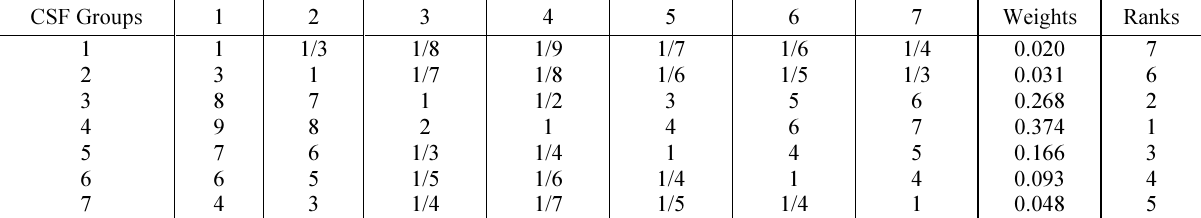
Table 2. Pairwise comparison of the main factor groups by on expert using the AHP method